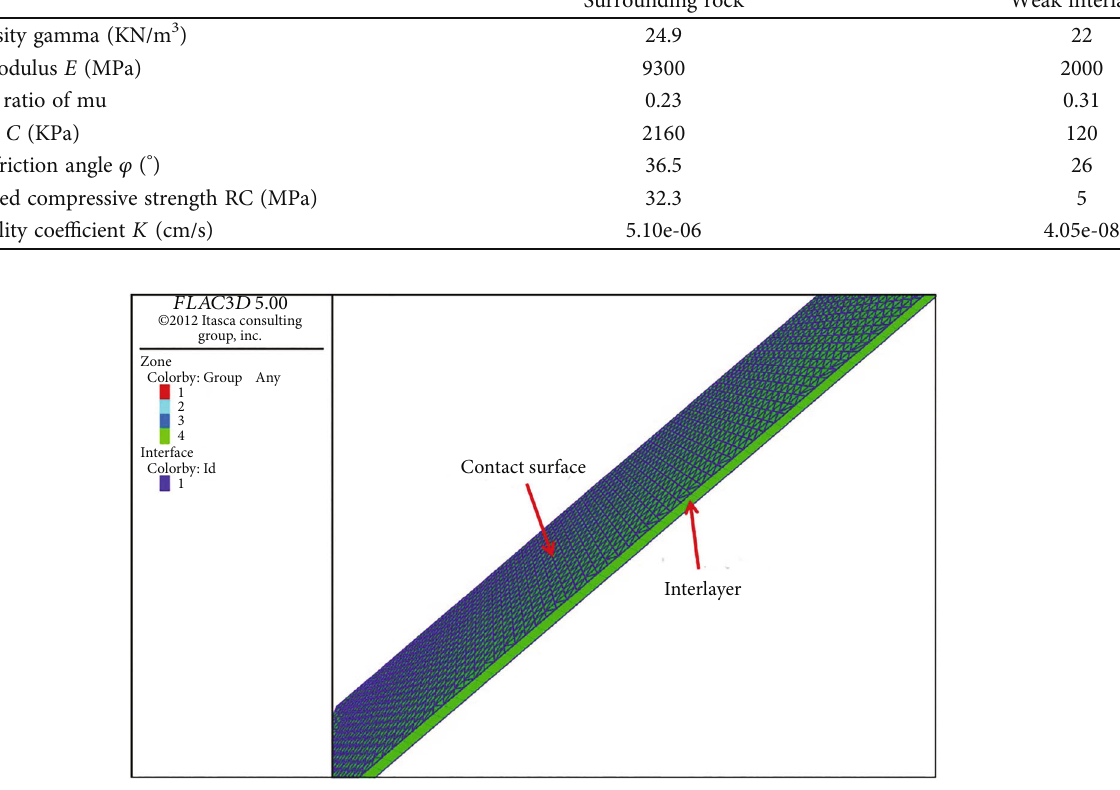
Figure 2: Contact surface and weak interlayer grid diagram.